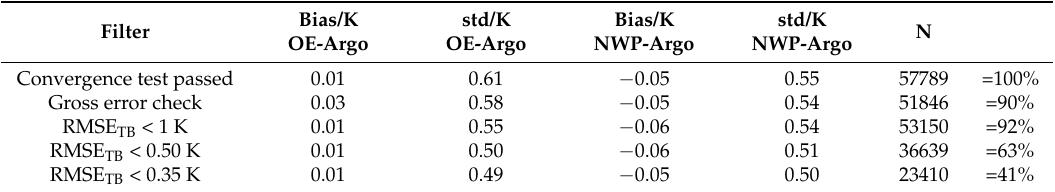
Table 4. Comparison of OE SSTs and NWP SSTs against Argo SSTs for various subsets.